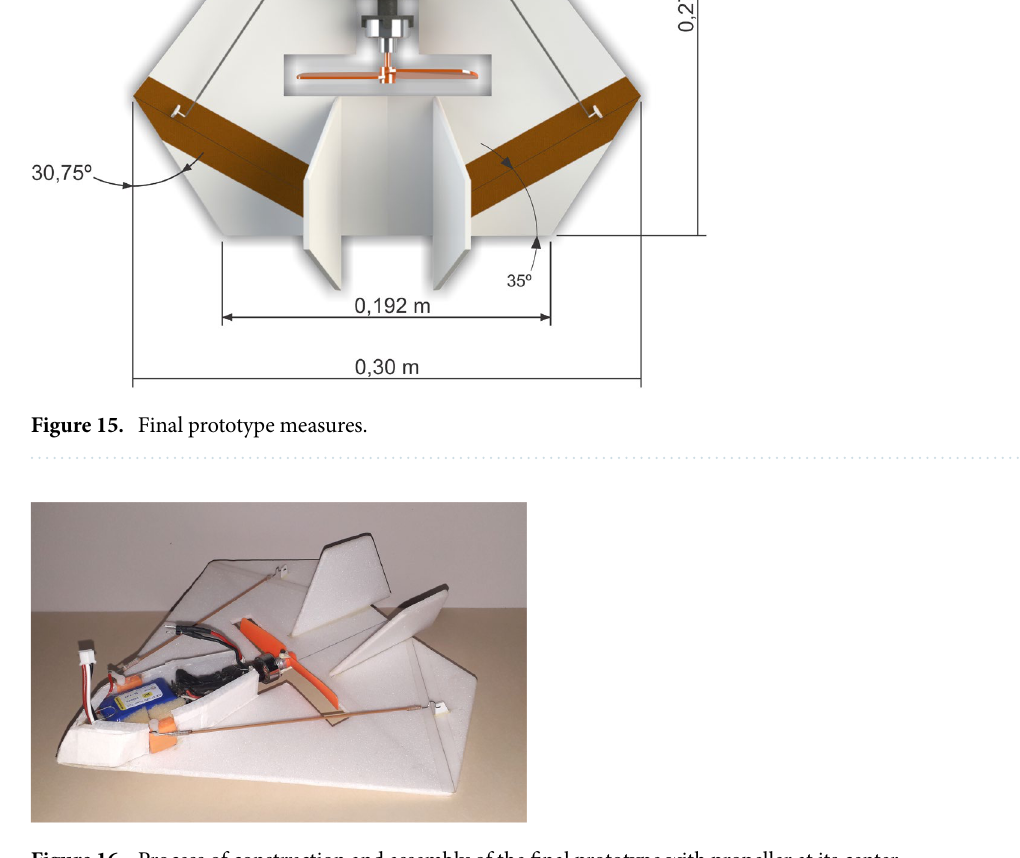
Figure 16. Process of construction and assembly of the final prototype with propeller at its